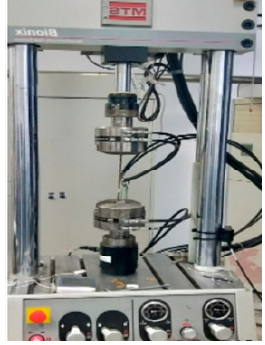
Figure 6. Tensile test of